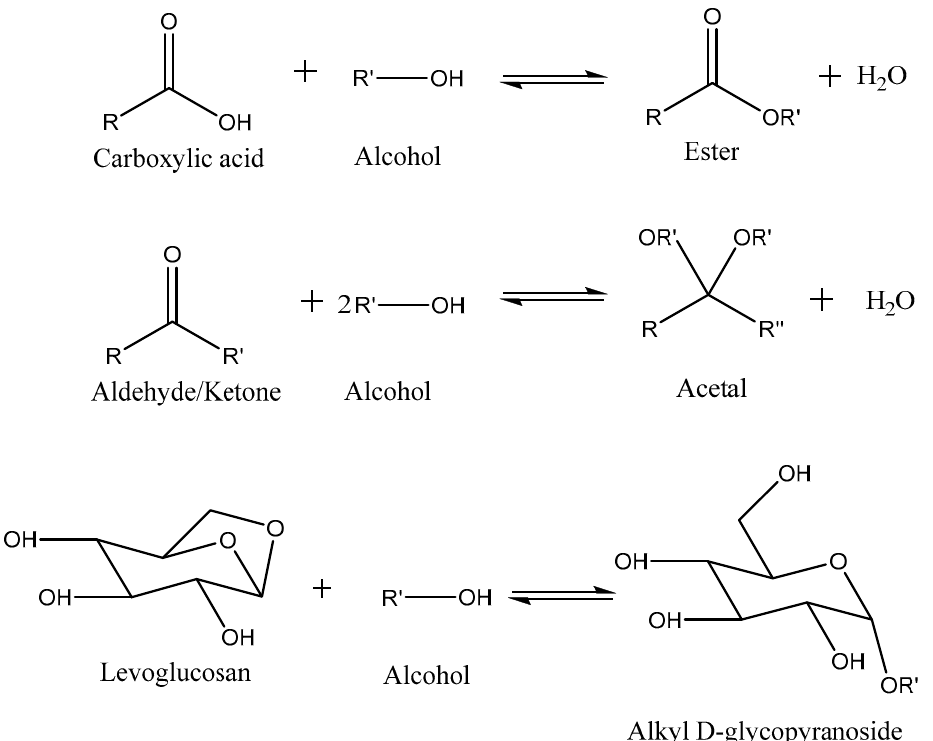
Figure 3. The main reactions occurring between bio-oil and alcohol during esterification treatment. Reprinted from reference [34].